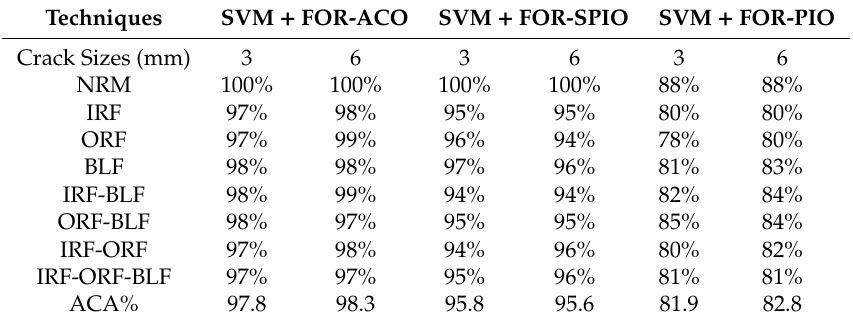
Table 13. The Accuracy of Multi-type Fault Identification When the Torque Speed is 500 RPM. Techniques SVM + FOR-ACO